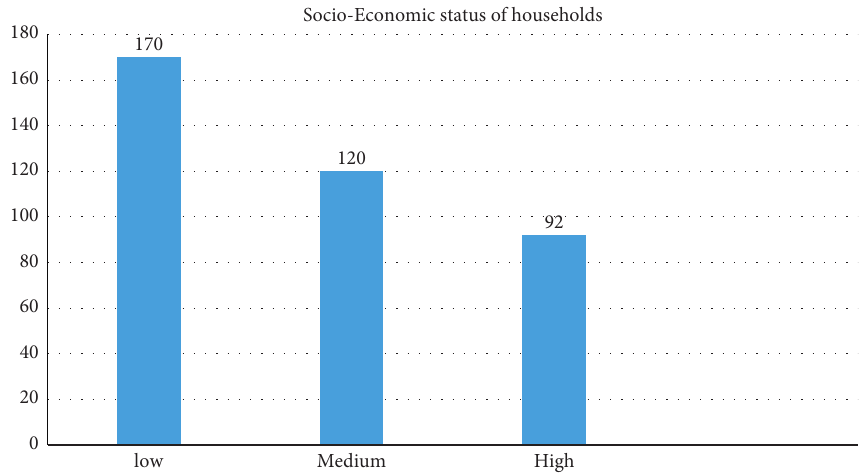
Figure 1: The level of the SES of households in Tepi